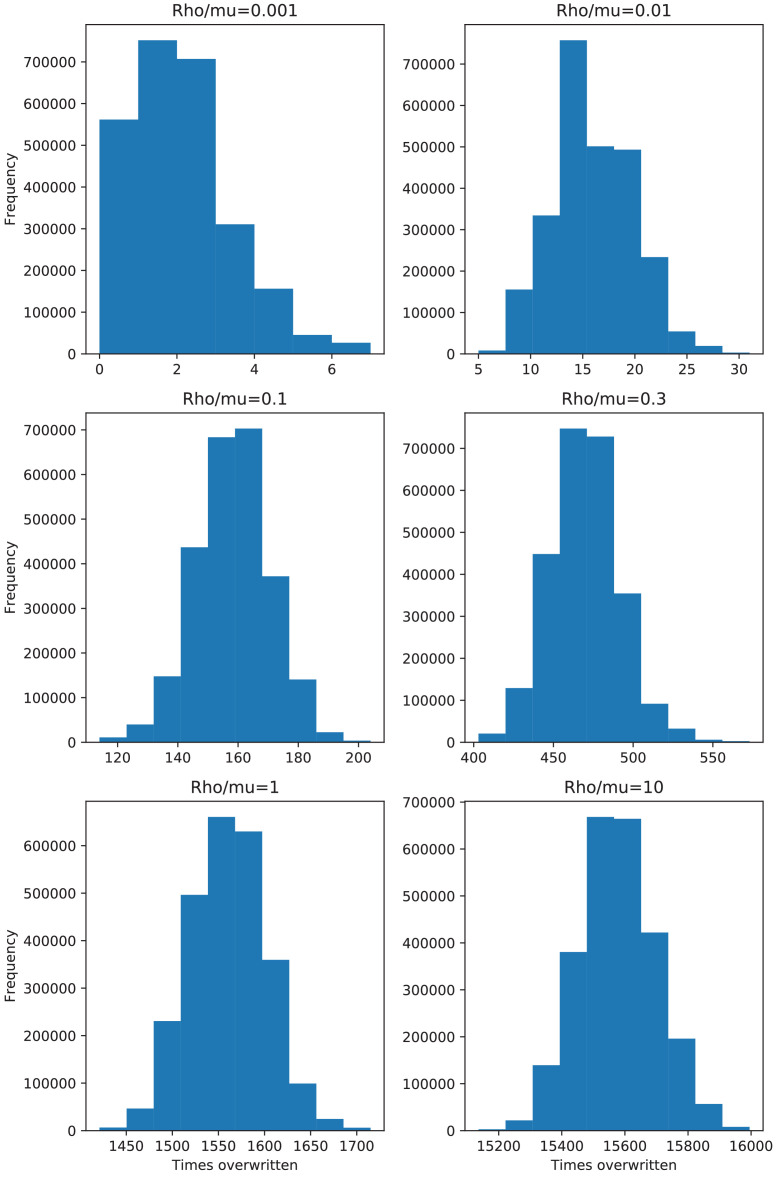
Distributions of the number of times each position in the alignment has been overwritten by recombination for the data of the simulations.Histograms of the number of times each position in the genome was overwritten by recombination along the branches of the clonal phylogeny, for the simulations with recombination-to-mutation ratios ranging from ρ/μ=0.001 (top left), to ρ/μ=10 (bottom right).